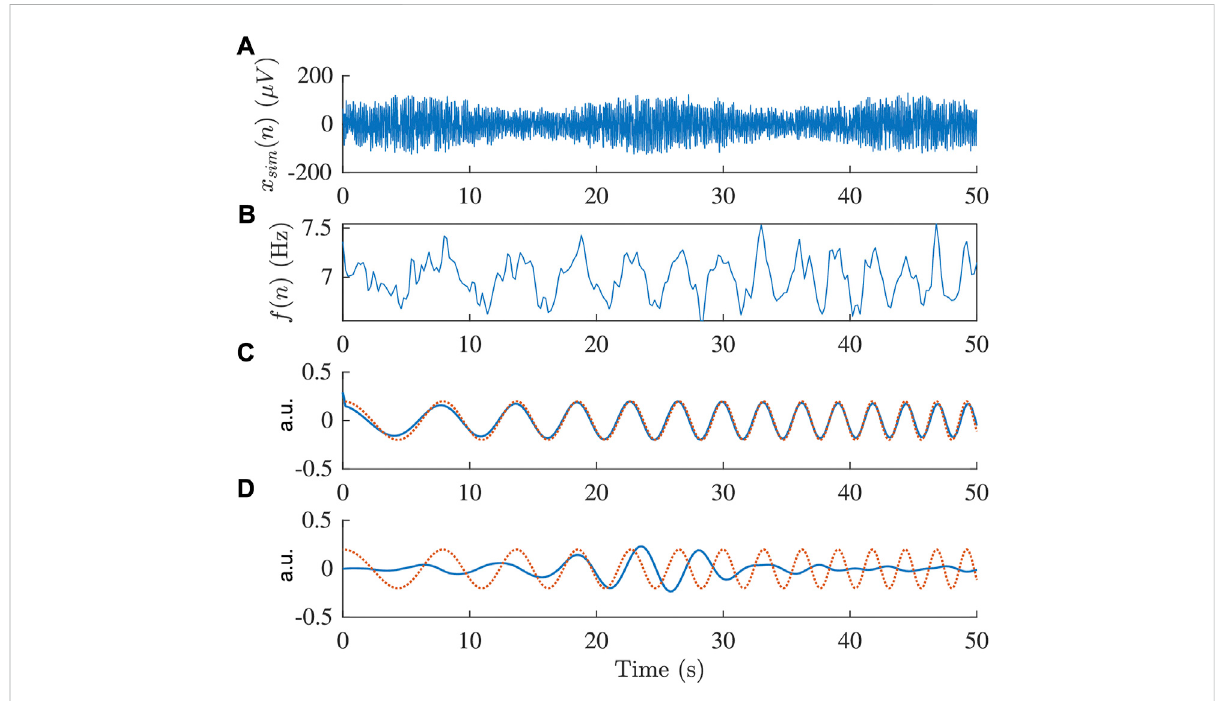
FIGURE 3 (A) Simulated signal x sim ( n ) and (B) corresponding estimated frequency trend f ( n ), respectively. (C,D) Modeled respiration signal (red) and extracted respiratory component (blue) obtained using (C) orthogonal subspace projection and (D) bandpass fi ltering.